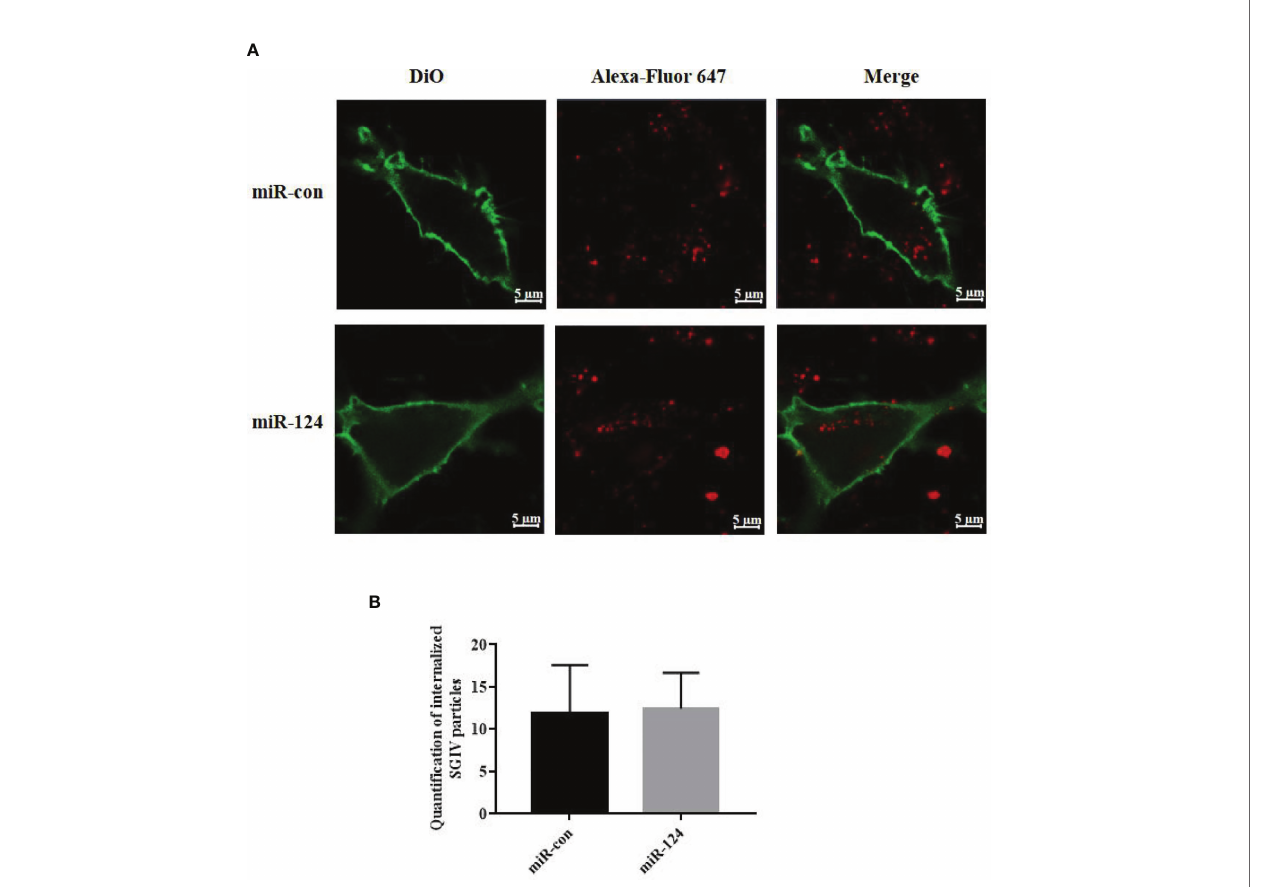
FIGURE 3 | The effect of miR-124 on the entry of Singapore grouper iridovirus (SGIV). (A) Three-dimensional confocal images of SGIV attachment in control mimics (miR-con) or miR-124 mimics (miR-124) transfected cells. The samples were stained with DiO to show the cell boundaries (green). The SGIV was labeled Alexa Fluor 647 (red). Scale bars represent 5 m m. (B) Quanti fi cation of internalized SGIV particles. Over 60 cells were randomly selected and analyzed by MATLAB program. The data are indicated as mean ± SD, N =